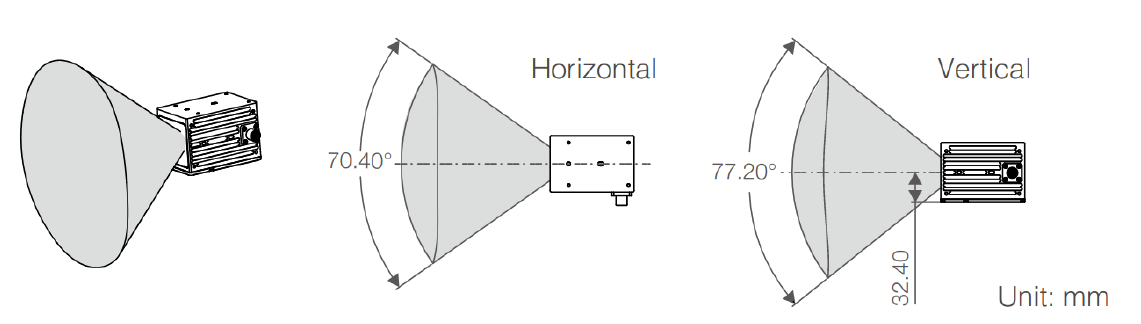
Figure 3. Field of view of the Livox Avia Lidar sensor (Avia User Manual, https://www.livoxtech.com,